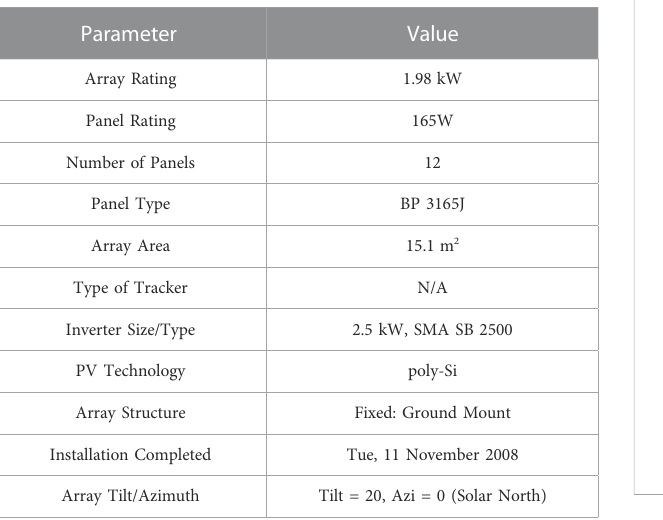
TABLE 1 Basic parameters of 16A_BP_Solar PV array.